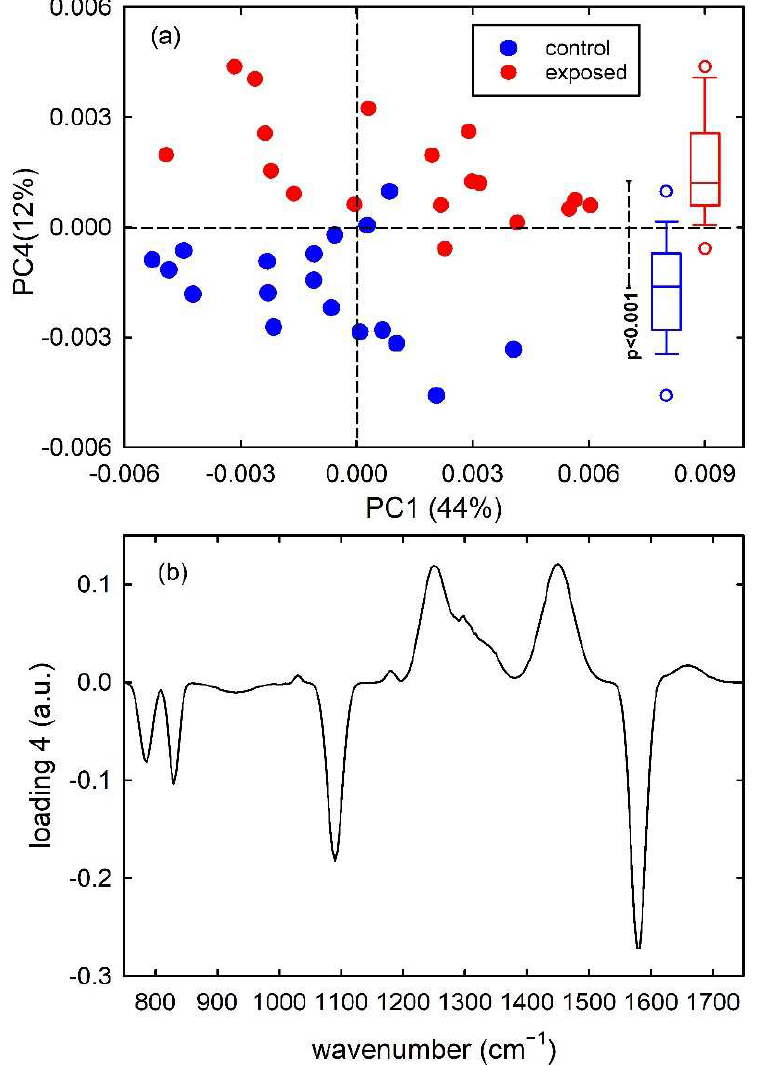
Figure 4. PC4 vs. PC1 score plot ( a ) for the synthetic control (blue dots) and exposed (red dots) vibrational spectra. The box plots of the PC4 score values are shown on the right side of ( a ): the results of the t-test point out that the two distributions of score values are significantly different ( p < 0.001). Loading 4 spectrum is reported in ( b ).